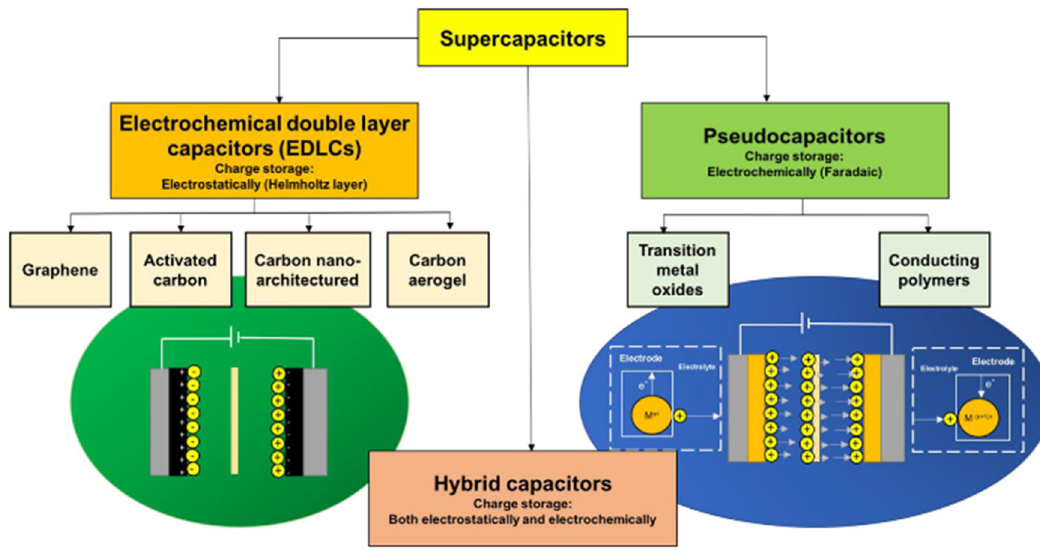
Figure 3: Classi fi cation of supercapacitors according to energy storage mechanisms: electrochemical double layer capacitors, pseudoca - pacitors, and hybrid capacitors [ 16 ]